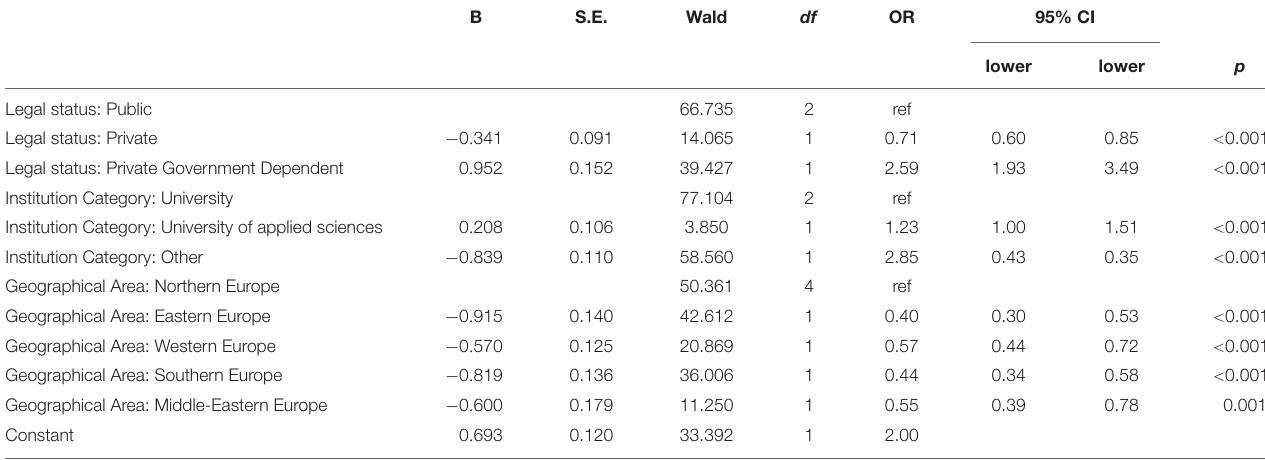
TABLE 7 | Effect estimates of independent variables on the availability of student counseling centers.